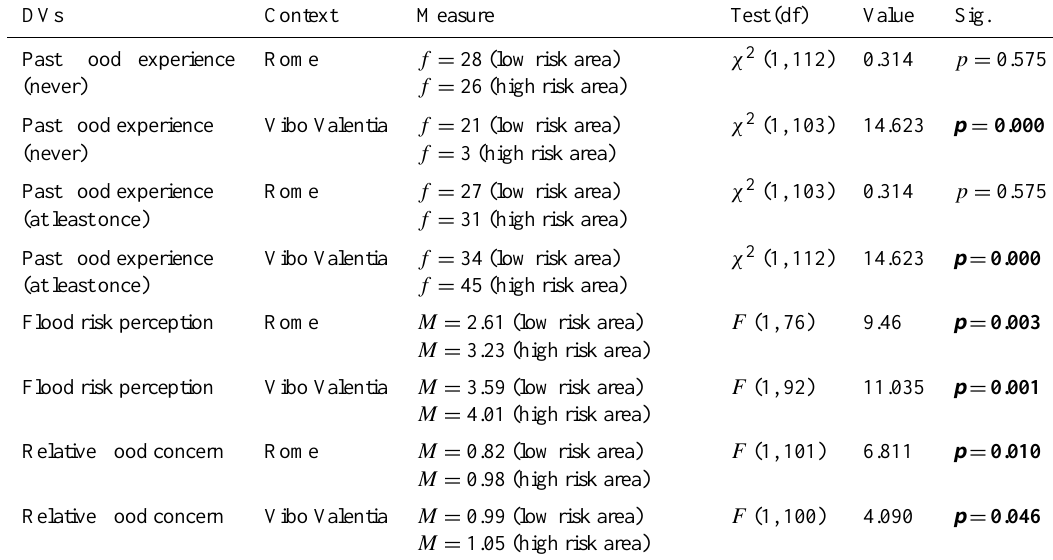
Table A1. URFlood survey results – within cities comparison ( f number/fraction of interviewed citizens with specific characteristics; M perception measure; p highlighted in bold depicts statistical significance at 5% level).